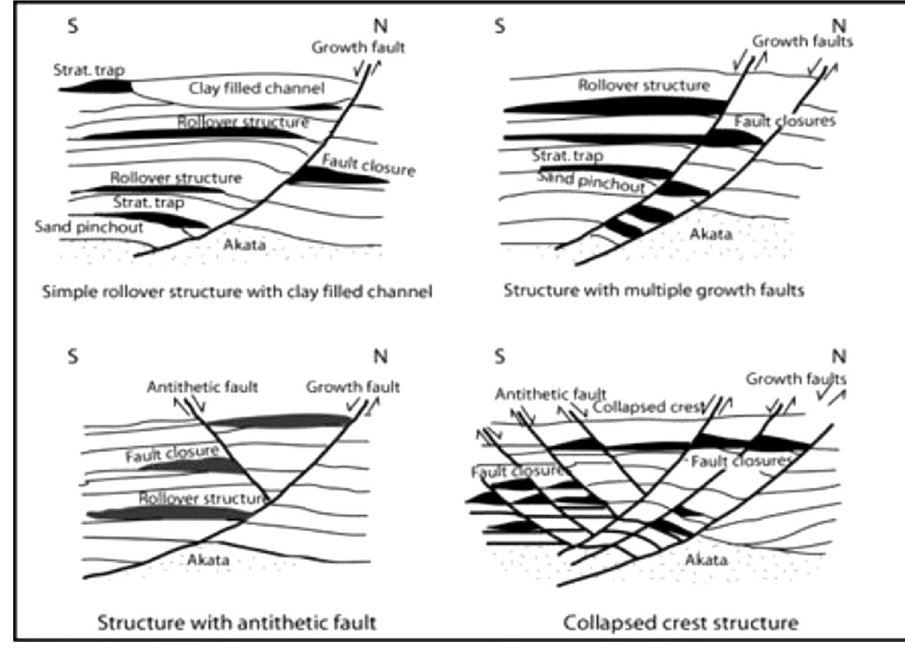
Fig. 6 Event chart for the Niger Delta (Akata/Agbada) petroleum system. (Doust and Omatsola